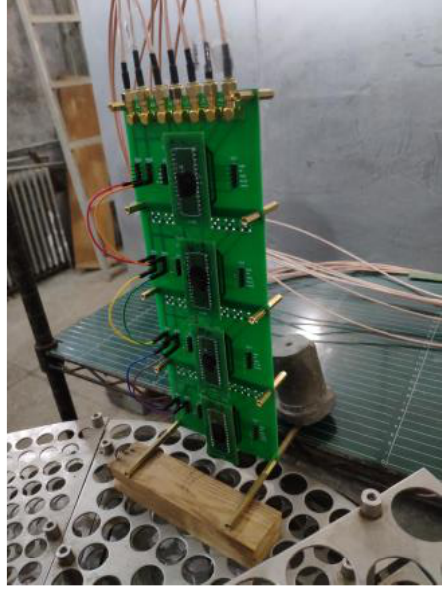
Figure 8. Gamma radiation facilities and the test board.